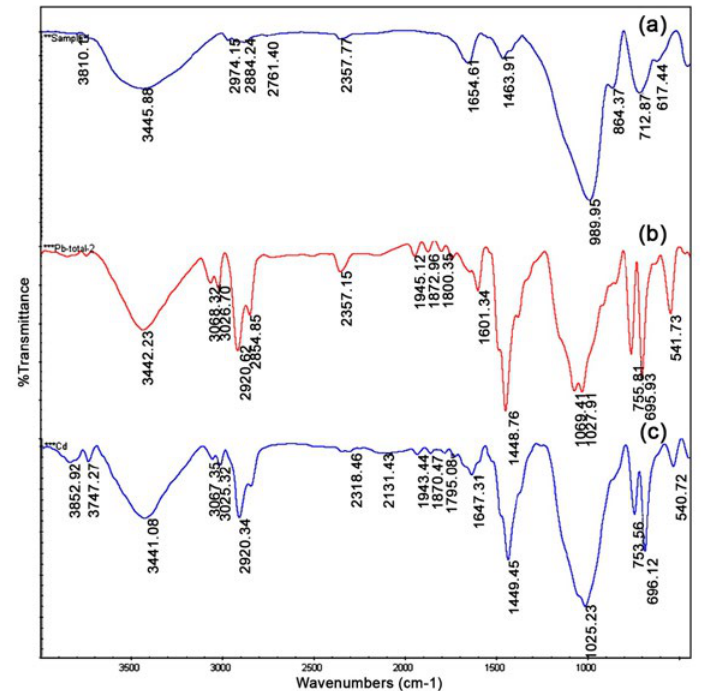
Fig. 3. FT-IR spectra of (a) zeolite N.P./PEG/GO composite, (b) zeolite N.P./PEG/GO composite after adsorbed Pb 2+ and (c) zeolite N.P./PEG/GO composite after adsorbed Cd 2+ ions